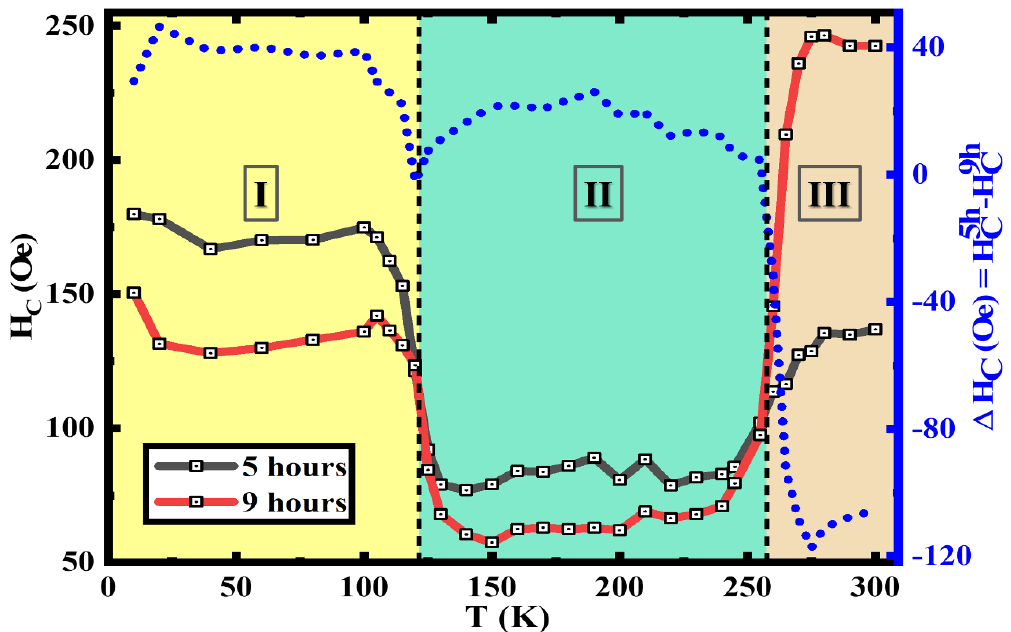
Figure 7. Temperature dependence of coercivity and coercivity difference between the 5 h annealed and 9 h annealed iron oxide nanorods.